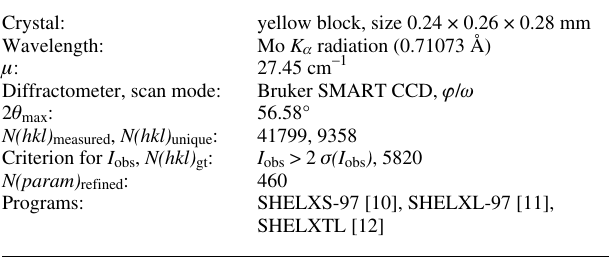
Table 1. Data collection and handling.